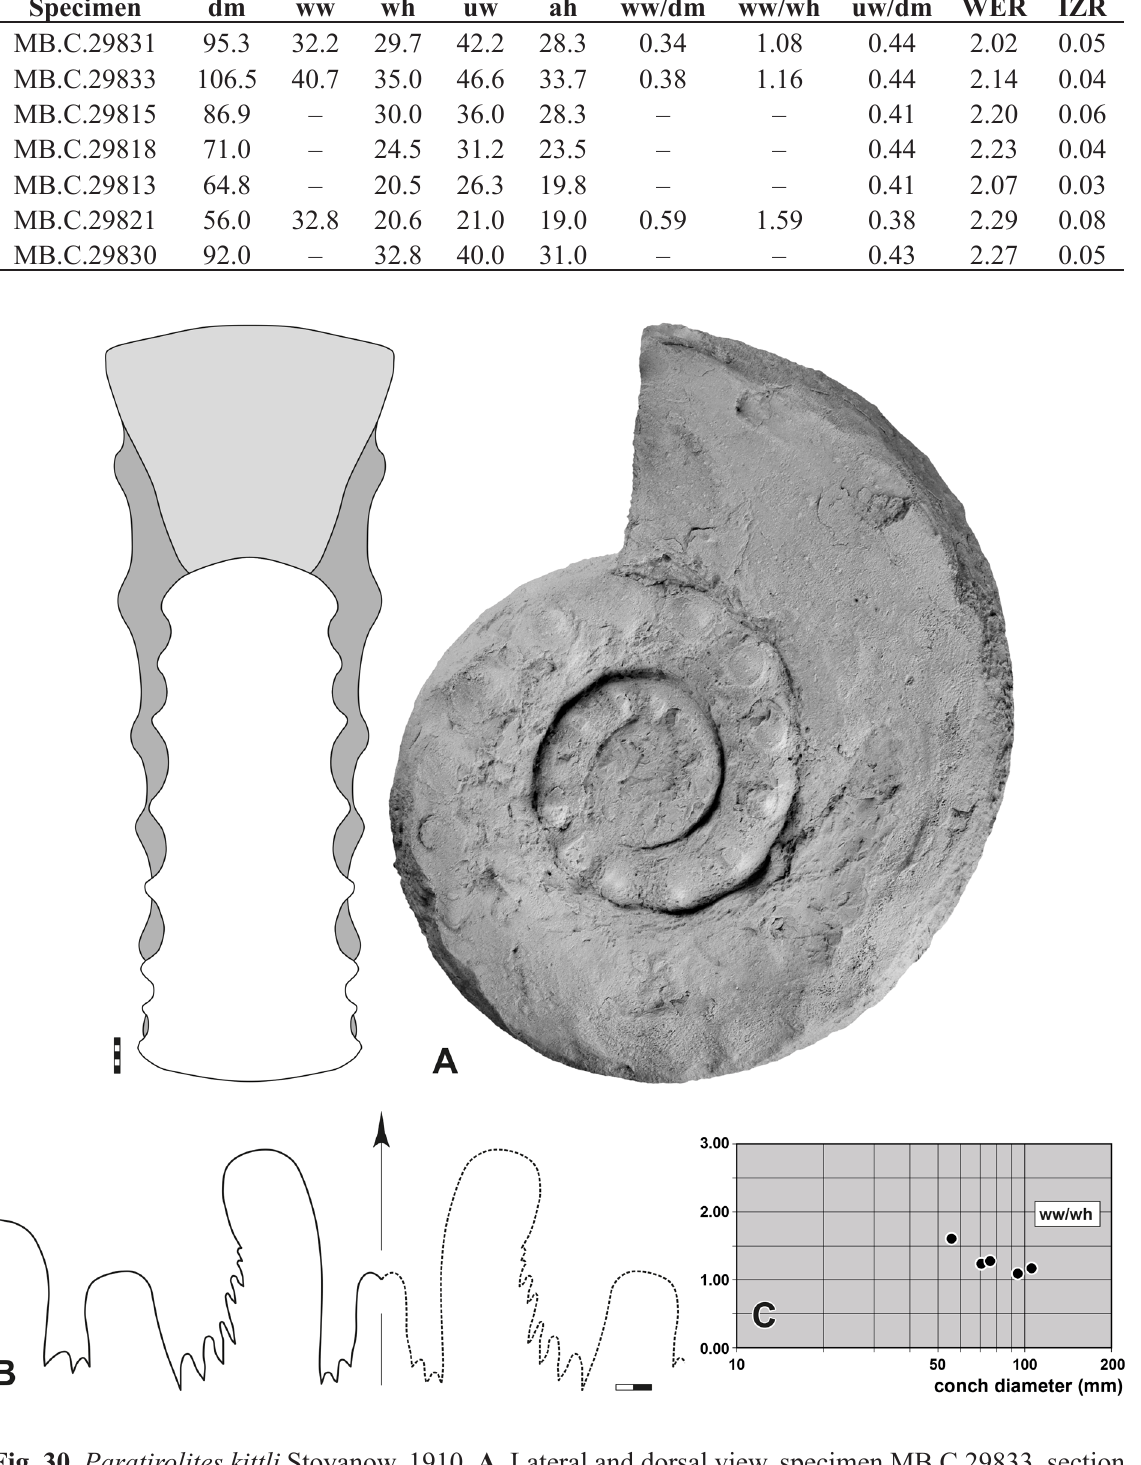
Fig. 30. Paratirolites kittli Stoyanow, 1910. A . Lateral and dorsal view, specimen MB.C.29833, section G, -2.75 m. B . Suture line, specimen MB.C.29833, at 30 mm ww, 16.0 mm wh. Abbreviations: see Material and methods. Scale bar units = 1